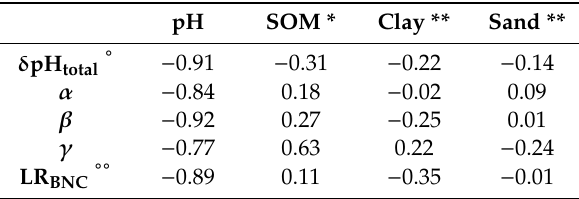
Table 4. Spearman’s rank correlation coe ffi cient of the partial correlation between the BNC parameters and the soil acidity and pH bu ff er capacity a ff ecting soil properties (pH, SOM, Clay and sand). pH SOM